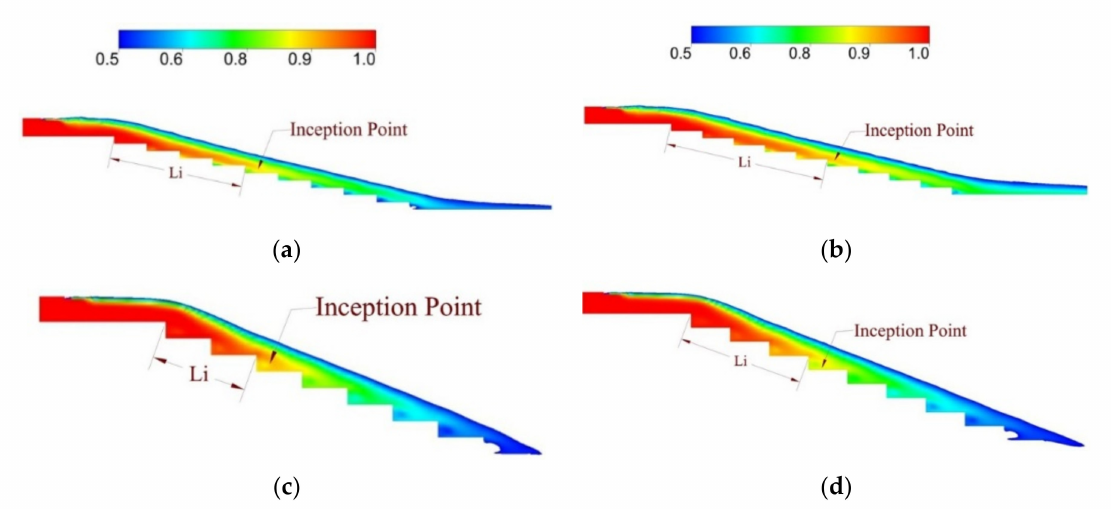
Figure 5. Water volume fraction contours of stepped spillway models with slopes of 12.5 ◦ and 20 ◦ at different discharge rates; ( a ) 12.5 ◦ model with discharge of 0.625 m 2 /s; ( b ) 12.5 ◦ model with discharge of 0.75 m 2 /s; ( c ) 20 ◦ model with discharge of 0.625 m 2 /s; ( d ) 20 ◦ model with discharge of 0.75 m 2 /s.